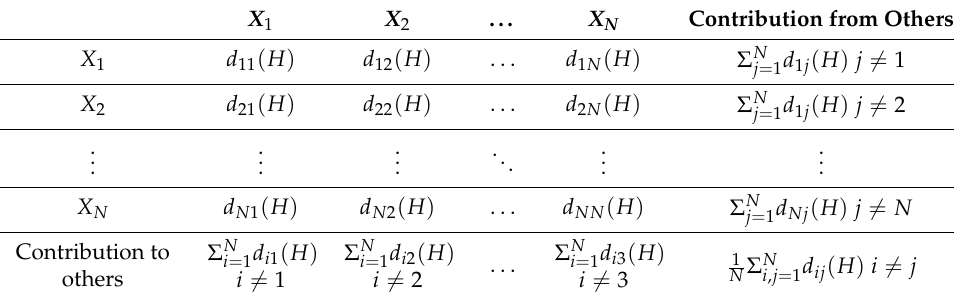
Table 1. Variance decomposition of Diebold and Yilmaz.